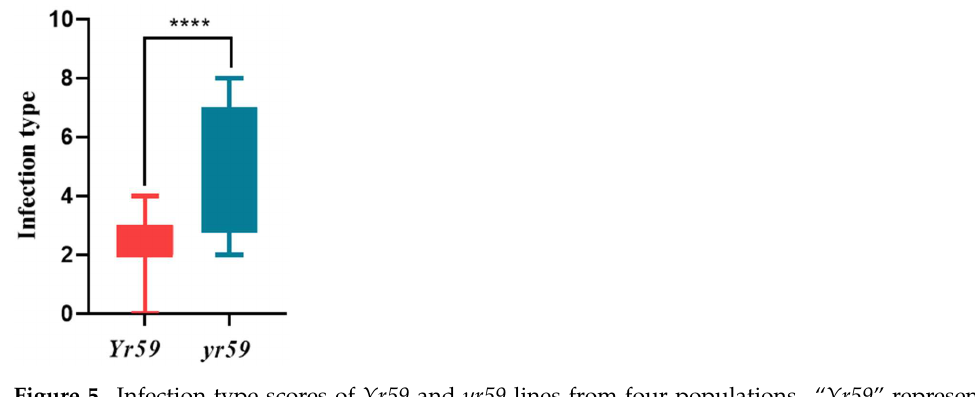
Figure 5. Infection type scores of Yr59 and yr59 lines from four populations. “ Yr59 ” represents the presence of Yr59 ; “ yr59 ” represents the absence of Yr59 . P -value was generated by the t -test. **** Significantly different at p < 0.05 (n.s., no significance at p > 0.05). Table 4. Yr genes detected by molecular markers, infection types (IT) and disease severity (DS) of stripe rust and agronomic traits of plant height (PH), number of spikes (NS), grain number per spike (GNS), spike length (SL) and thousand-grain weight (TWG) of parents and progeny lines. Stripe Rust Agronomic Trait Line Parent/Crosses